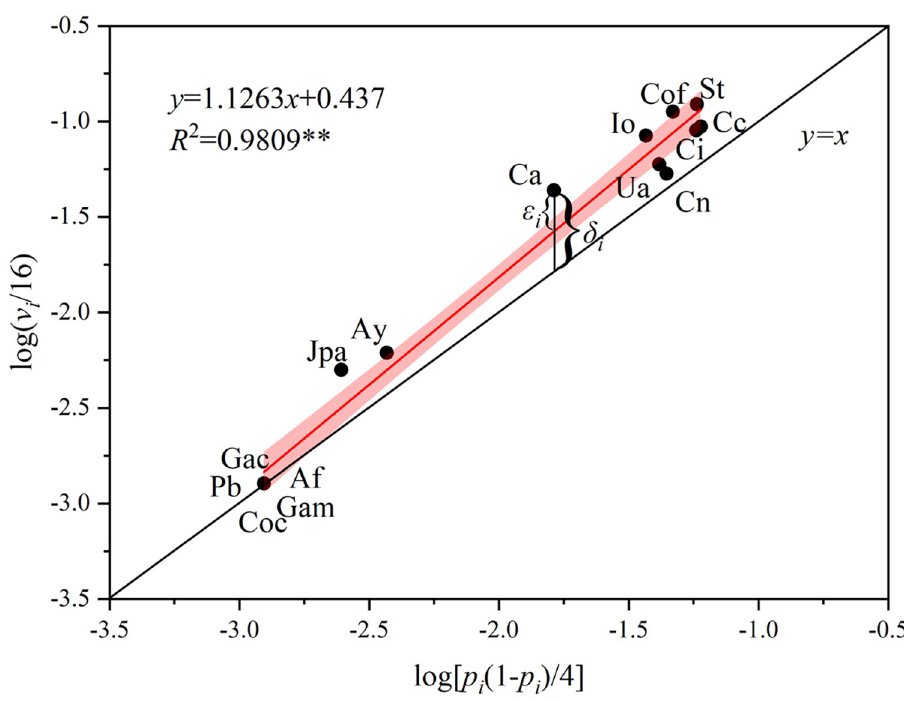
Fig 3. The relationship among macroalgae species occurrence frequencies and the power law model. �� was significantly correlated (p < 0.01). The y = x line (black line) represents random spatial distribution. Species of macroalgae (black dots) were plotted, and the line of best fit was generated (red line) with the 95% confidence intervals (pink area). The value of spatial heterogeneity of species i compared to random distribution in the intertidal zone was calculated as the vertical distance from every point to y = x straight line ( δ i ). The value of spatial heterogeneity of species i compared to the whole community was calculated as the vertical distance from every point to the fitting line ( ε i ). Species (black dot) abbreviations: Callophyllis adnata (Ca), Corallina officinalis (Cof), Ishige okamurae (Io), Sargassum thunbergii (St), Jania pedunculata var. adhaerens (Jpa), Alatocladia yessoensis (Ay), Chondria crassicaulis (Cc), Chondracanthus intermedius (Ci), Ulva australis (Ua), Chondrus nipponicus (Cn), Grateloupia acuminata (Gac), Chondrus ocellatus (Coc), Ahnfeltiopsis flabelliformis (Af), Gelidium amansii (Gam), Petalonia binghamiae (Pb).